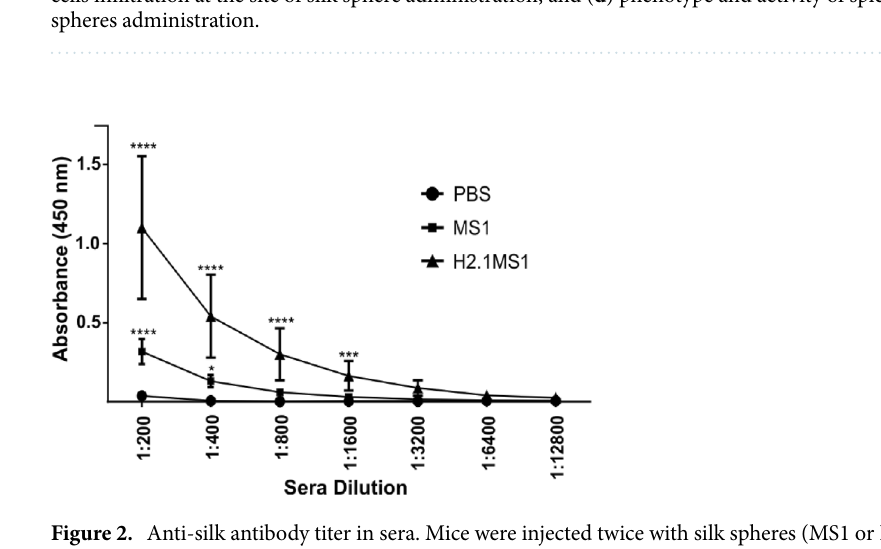
Figure 2. Anti-silk antibody titer in sera. Mice were injected twice with silk spheres (MS1 or H2.1MS1) or PBS. After 28 days, serum samples were collected and anti-silk antibody titers were measured using an ELISA-type assay. The results are expressed as the means ± SD for 10 animals per group. *Denotes significance at p ≤ 0.05, ***p ≤ 0.001, and ****p ≤ 0.0001